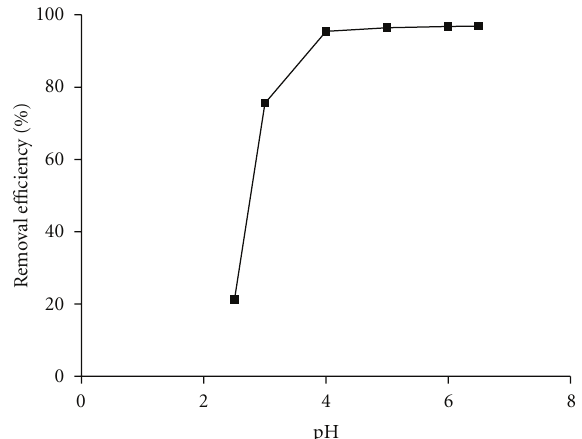
Figure 5: E ff ect of pH on Pb 2+ adsorption onto γ -Fe 2 O 3 nanoad- sorbents. Initial Pb 2+ concentration: 50 mg/L. Adsorbent dose: 10g/L, shaking rate: 200 rpm, T : 22 ± 2 o